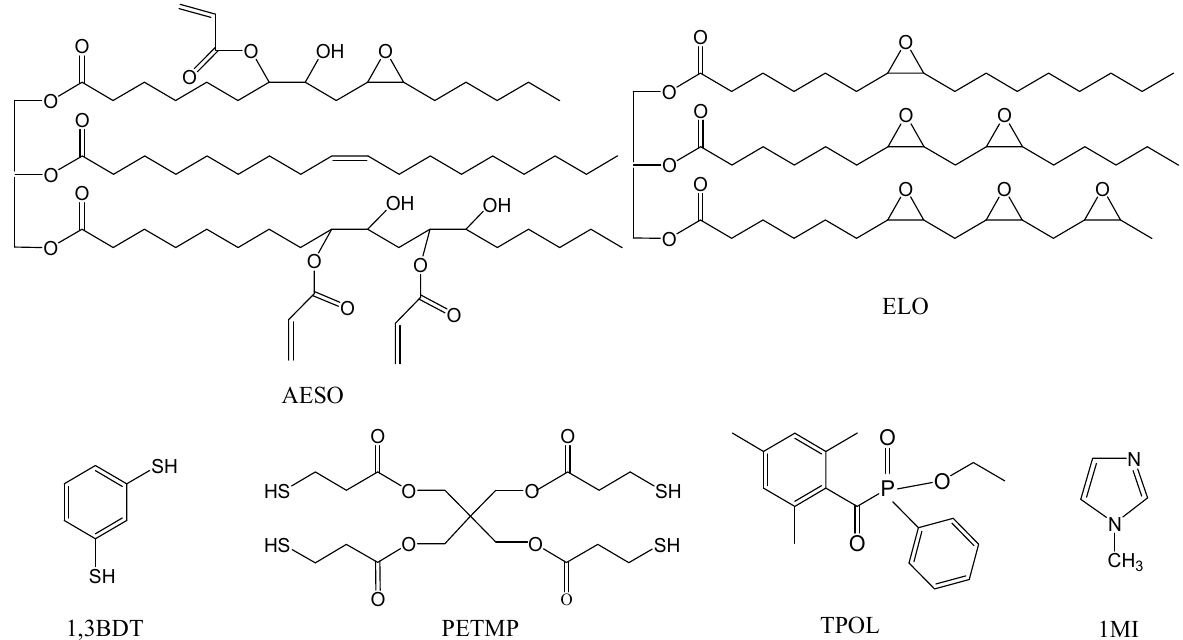
Figure 1. Chemical structures of acrylated epoxidized soybean oil (AESO), epoxidized linseed oil (ELO), benzene-1,3-dithiol (1,3BDT), pentaerythritol tetra(3-mercaptopropionate) (PETMP), ethyl (2,4,6-thimethylbenzoyl) phenyl phosphinate (TPOL), and 1-methylimidazole (1MI).